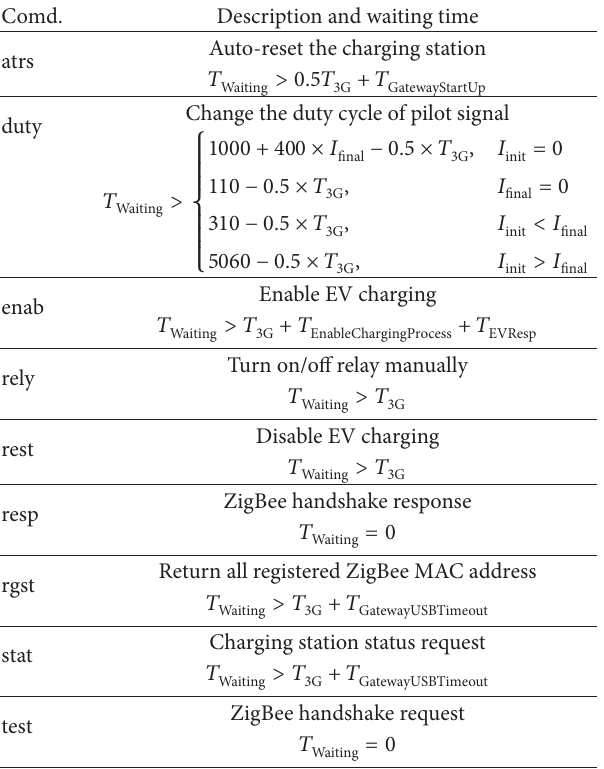
Table 1: Waiting time of command sets.